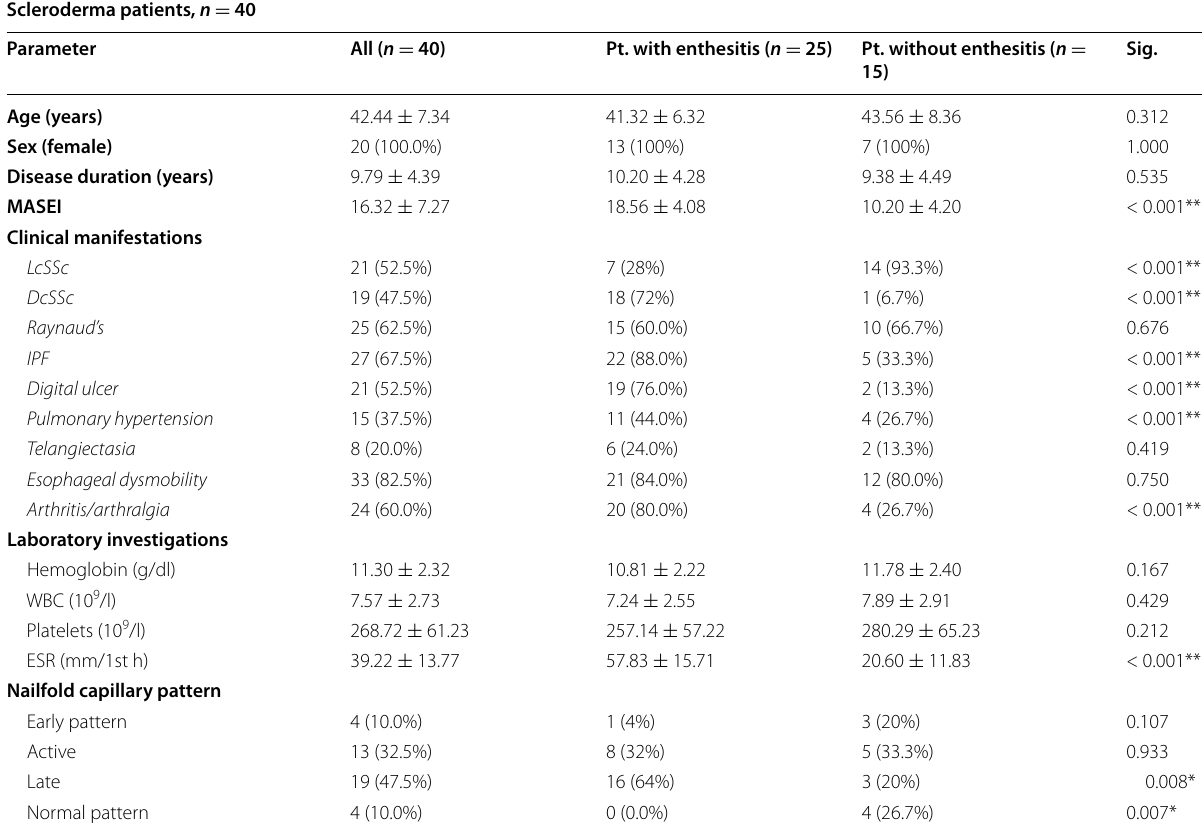
Table 2 Comparison between scleroderma patients with and without enthesitis detected by ultrasound regarding demographic, clinical, and laboratory